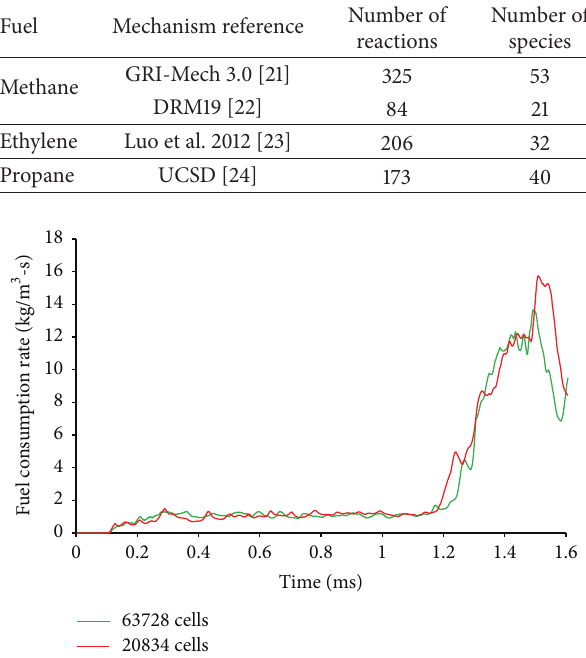
Figure 3: Fuel consumption rate integrated over the CVC chamber for the two grids for methane mixture using DRM19 reaction